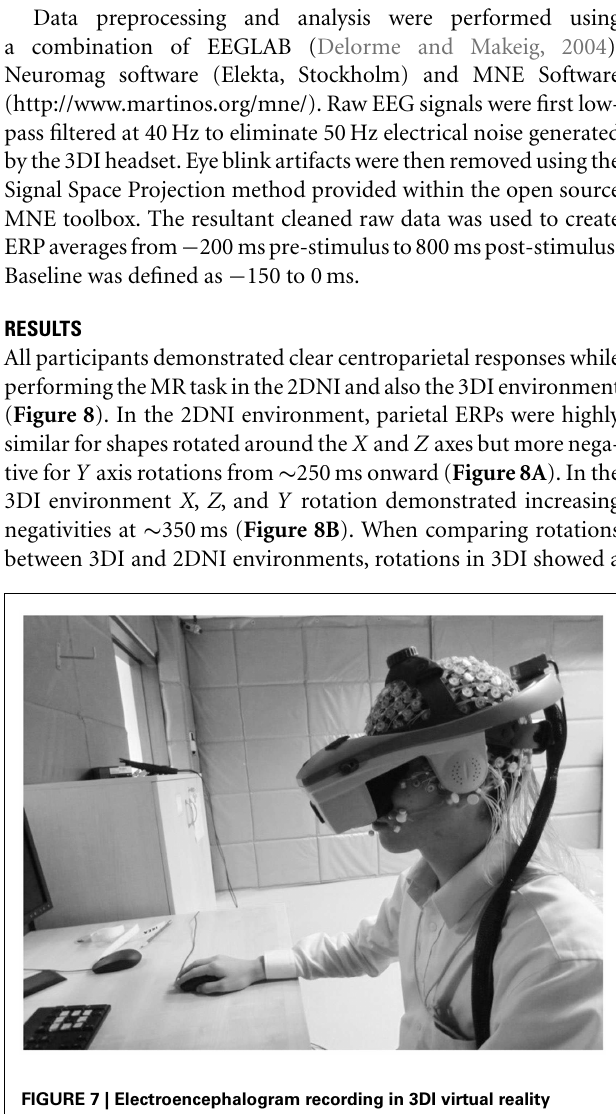
FIGURE 7 | Electroencephalogram recording in 3DI virtual reality